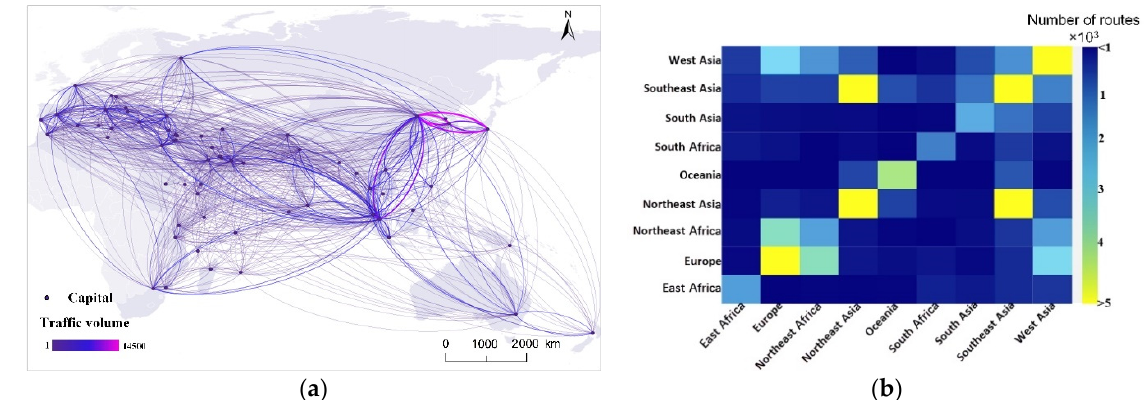
Figure 5. Formalization of maritime traffic flow distribution: ( a ) Shipping topological network of maritime traffic flow. The visualization is made by Gephi; ( b ) Thermal map of route distribution. The lighter the color, the greater the maritime traffic volume between the two regions. Table 2. The ratio of top 20% of the traffic volume to total traffic volume in the region.